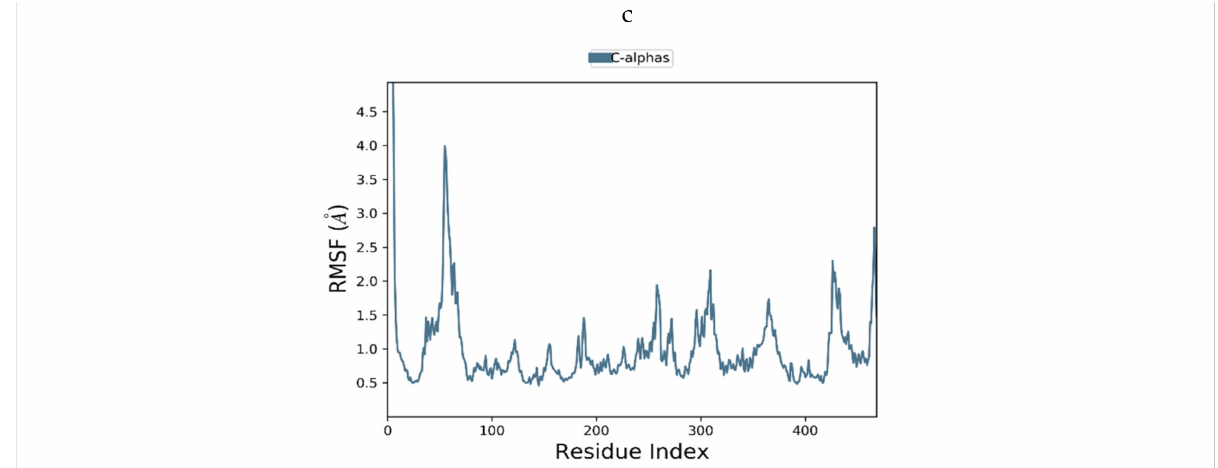
Figure 15. ( a – c ) RMSF plots for GLUT-4 and with selected compounds: ( a ) Quercitin, ( b ) Kaempferol, and ( c ) Trans-Ferulic